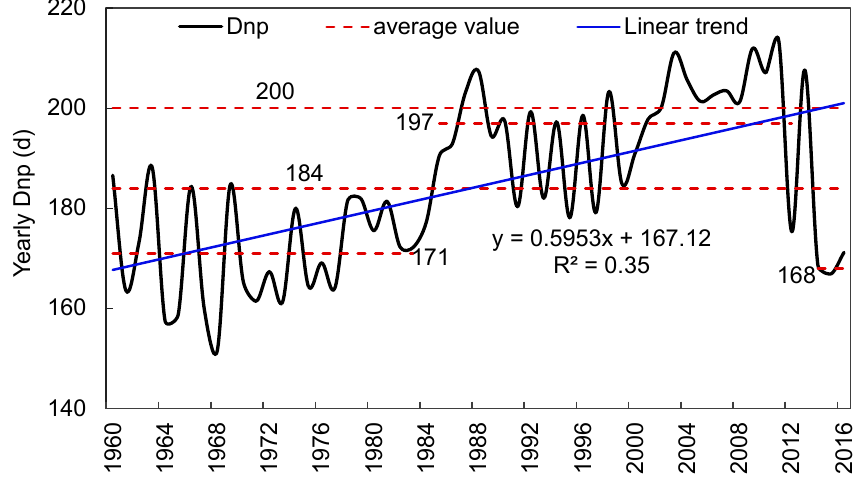
Figure 2. The spatial distribution of meteorological stations in Guizhou.